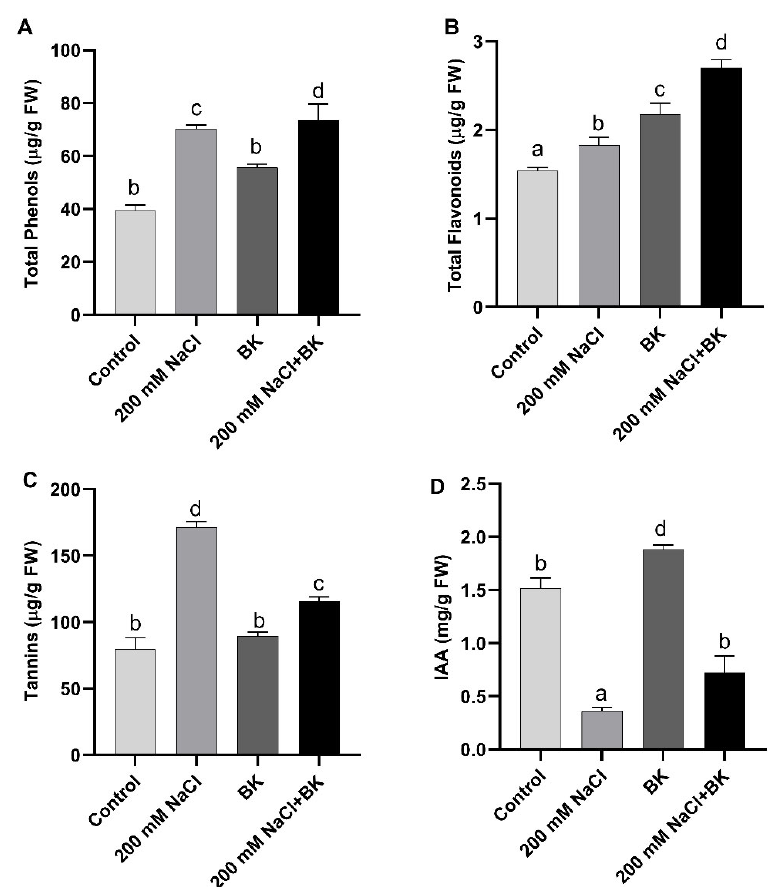
Figure 5. Influence of A. welwitschiae BK on secondary metabolites. ( A ) Total phenols, ( B ) total flavonoids, ( C ) tannin, and ( D ) IAA level of maize raised under salt stress. Data represent the means and SE of three independent replicates for each treatment. Significant differences ( p ≤ 0.05) are marked with different le tt ers.